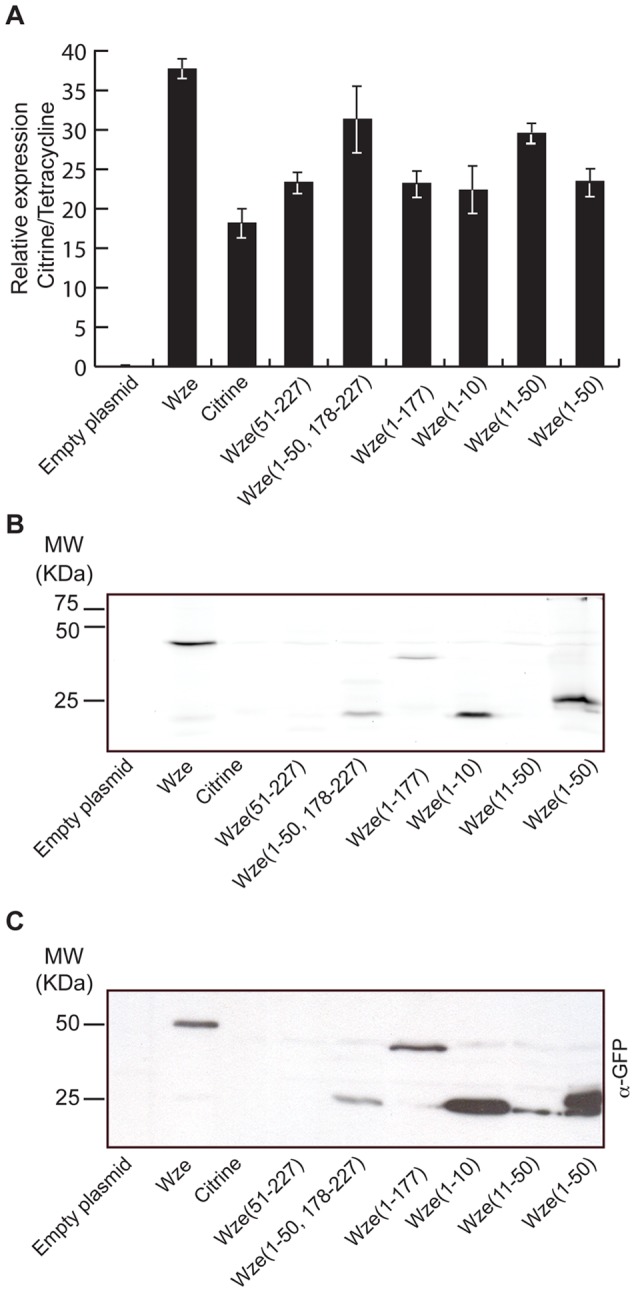
Increased fluorescence resulting from the presence of the “i-tag” is due to increased protein levels.(A) mRNA encoding Citrine was quantified by Real-time PCR in strains expressing specific aminoacid sequences from Wze fused to Citrine, relatively to the mRNA for the tetracycline resistance protein which is encoded in the plasmid backbone. Strains analyzed were BCSMH031 (transformed with an empty vector), BCSMH007 (expressing full Wze-Citrine), BCSMH033 (expressing Citrine), BCSJC003 (expressing Wze(51–227)-Citrine), BCSJC004 (expressing Wze(1–50, 178–227)-Citrine), BCSJC005 (expressing Wze(1–177)-Citrine), BCSJC001 (expressing Wze(1–10)-Citrine), BCSJC007 (expressing Wze(11–50)-Citrine) and BCSJC002 (expressing Wze(1–50)-Citrine). Cell extracts from these strains were separated by SDS-Page and analyzed using a Fluorescent Image Analyzer (B) and by Western-blot analysis using an antibody that recognizes Citrine protein (C), showing that fluorescence in strains containing the i-tag is due to increased protein levels and not to increased mRNA levels.